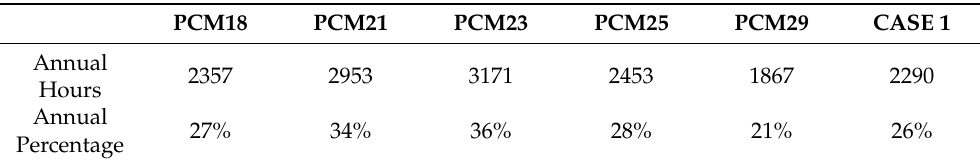
Table 6. Annual hours and correspondent percentage value in which the indoor air temperature is